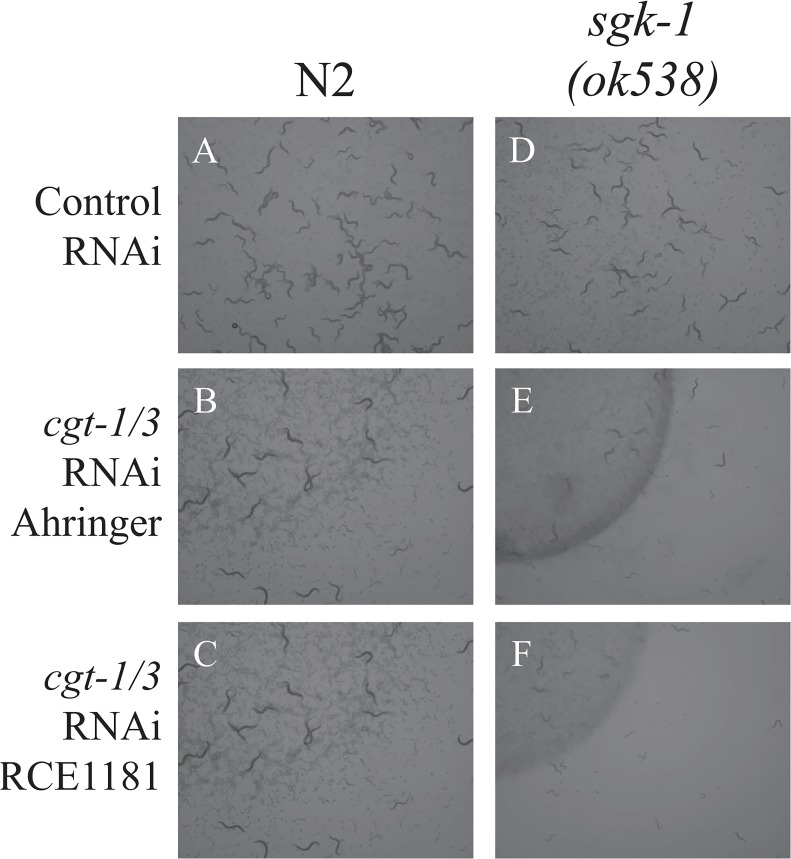

sgk-1 mutant worms treated with cgt-1/3 double RNAi developed very slowly.Images of wild type (A, B, C) and sgk-1(ok538) mutant animals (D, E, F) treated with control RNAi (A, D) and cgt-1/3 double RNAi from Ahringer library (B, E) and RCE1181 library (C, F). The experiments started with 5 gravid adult worms on each plate and the plates were imaged 5 days later.